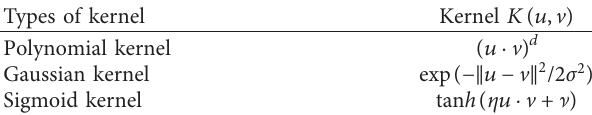
Figure 2: RNN cell.